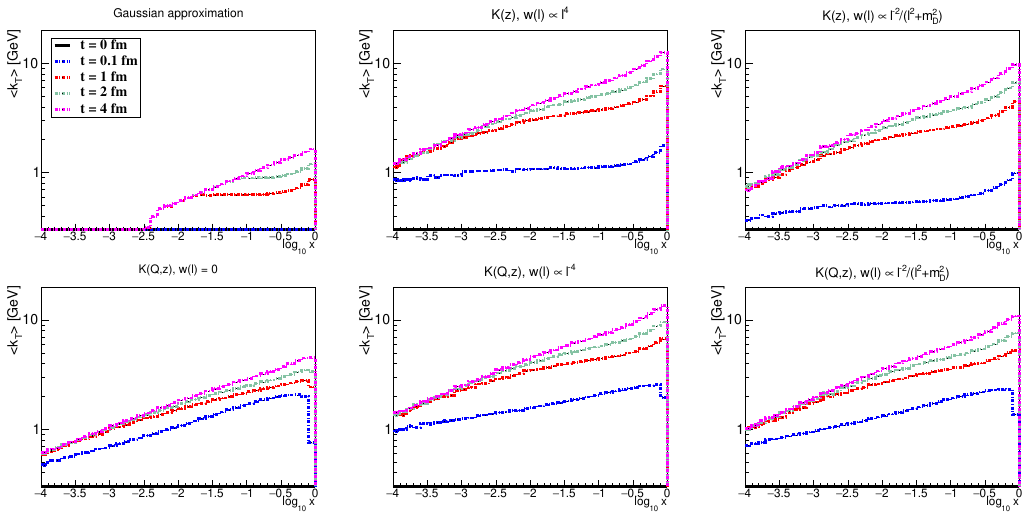
Figure 3 . The h k T i vs. log x distributions for the evolution time values t = 0 , 0 . 1 , 1 , 2 , 4 fm, 10 for different kernels: the Gaussian approximation, K ( z ) and K ( Q , z, p + ) (denoted as K(Q , z) ), and different collision terms: no collision term, the collision term as in eq. (2.6) and in eq. (2.7), respec-